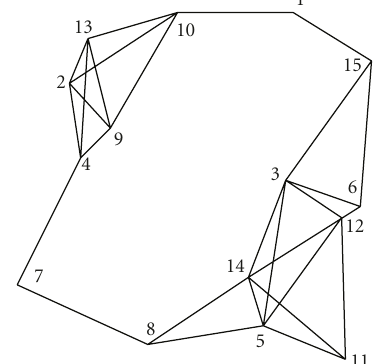
Figure 4: Random topology for the